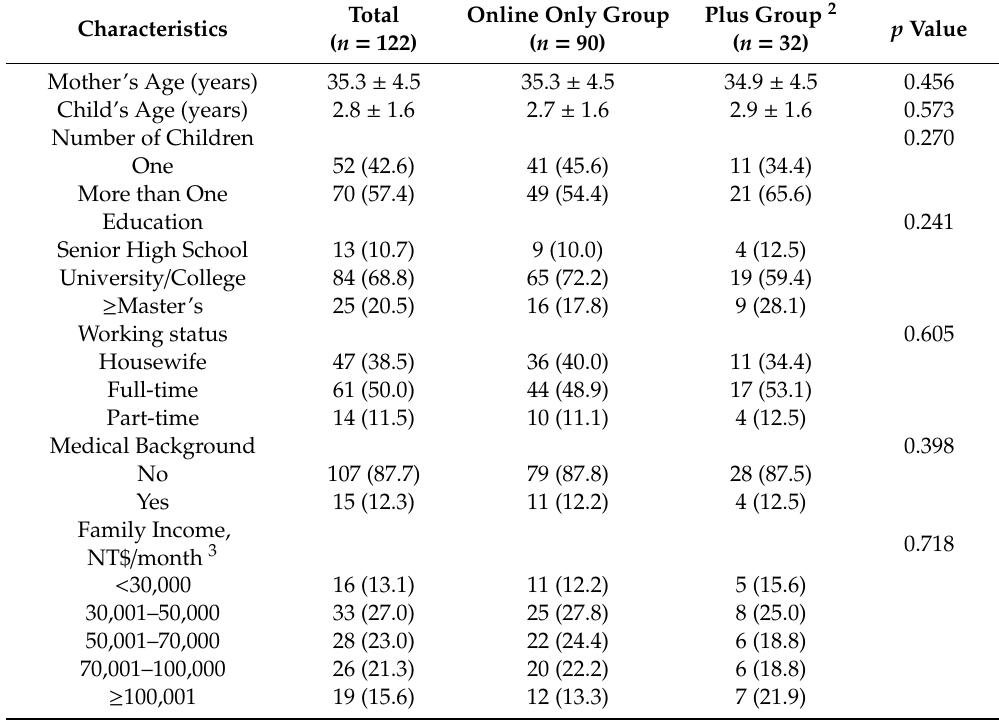
Table 1. Demographic characteristics of participants by the intervention condition 1